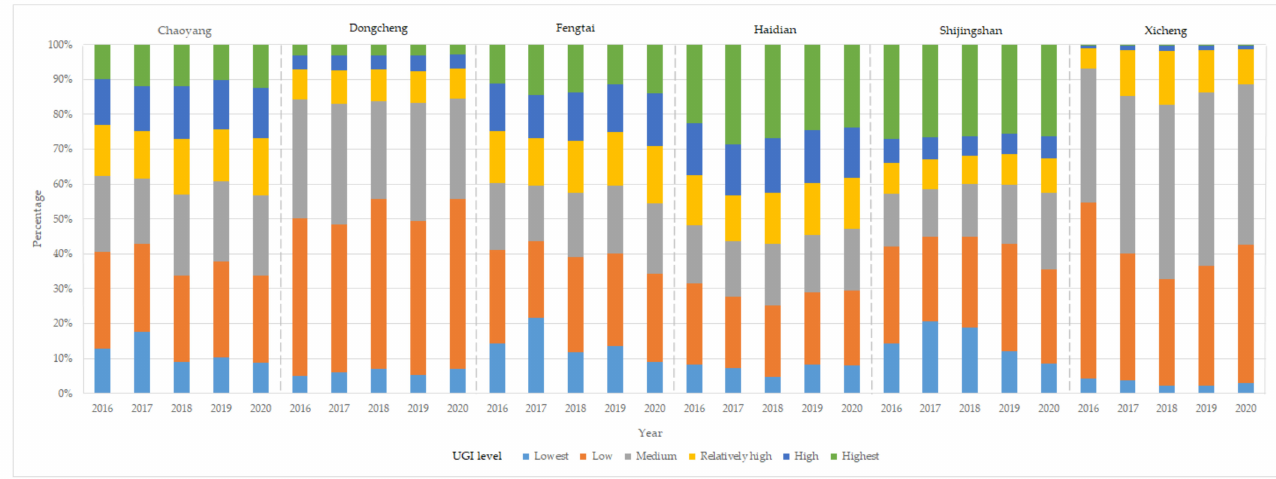
Figure 7. Percentage of different levels of UGI in six